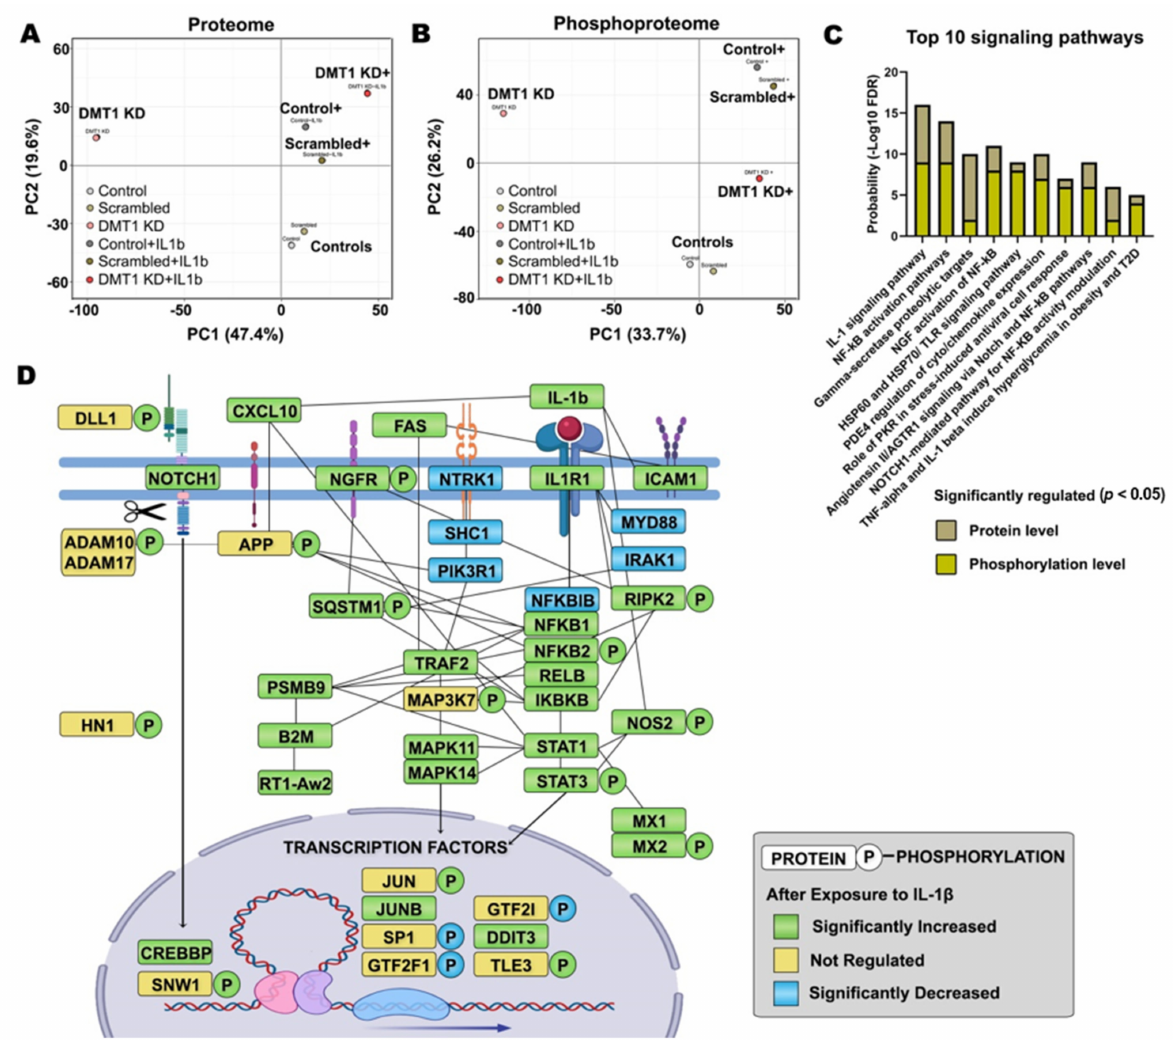
Figure 2. The pro-inflammatory effect in IL-1 β exposed pancreatic β -cells. ( A ) PCA plots of the averaged proteome profiles of Control ( − ) (light grey), Scrambled ( − ) (light brown), DMT1 KD ( − ) (pink), Control + IL-1 β (dark grey), Scrambled + IL- 1 β (dark brown), DMT1 KD + IL1b (red) cells. ( B ) PCA plots of the averaged phosphoproteome profiles of Control ( − ) (light grey), Scrambled ( − ) (light brown), DMT1 KD ( − ) (pink), Control + IL-1 β (dark grey), Scrambled + IL-1 β (dark brown), DMT1 KD + IL-1 β (red) cells. ( C ) Significantly enriched top 10 signaling pathways (FDR < 0.05) are classified in regulated proteins and phosphopeptides in the comparison of SC and SC-IL. (beige bar: probability from the proteome, gold bar: probability from the phosphoproteome) ( D ) protein-protein interaction network across IL-1 β -regulated proteins and protein phosphorylation. P, phosphosite. (green: significantly increased, blue: significantly decreased, yellow: not significantly